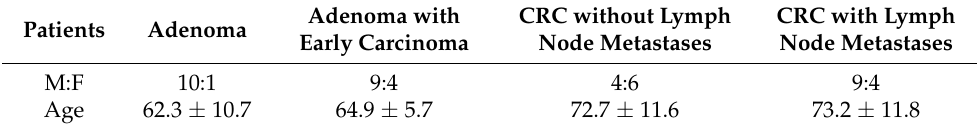
Table 2. Demographic characteristics of the included